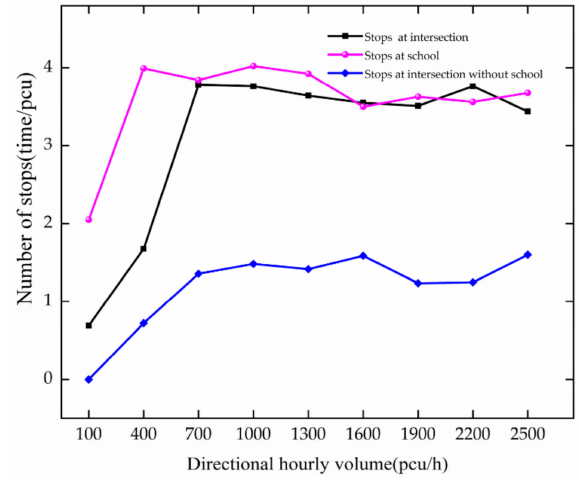
Figure 8. Variation trend of stops with DHV.